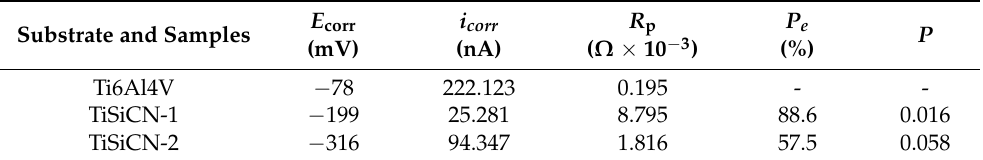
Table 4. Electrochemical parameters of the investigated samples after 1 h immersion in 3.5% NaCl: E corr : corrosion potential; i corr : corrosion current density; R p : polarization resistance; P : porosity; P e : protective